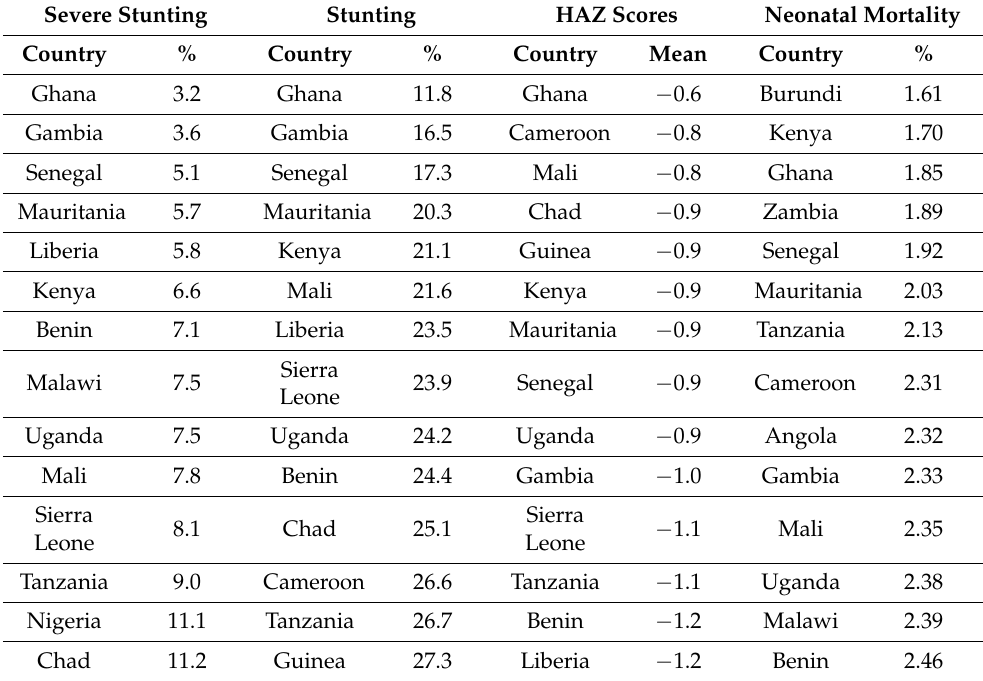
Table 2. Country ranking by prevalence and mean for the four outcomes among youngest child under two years of